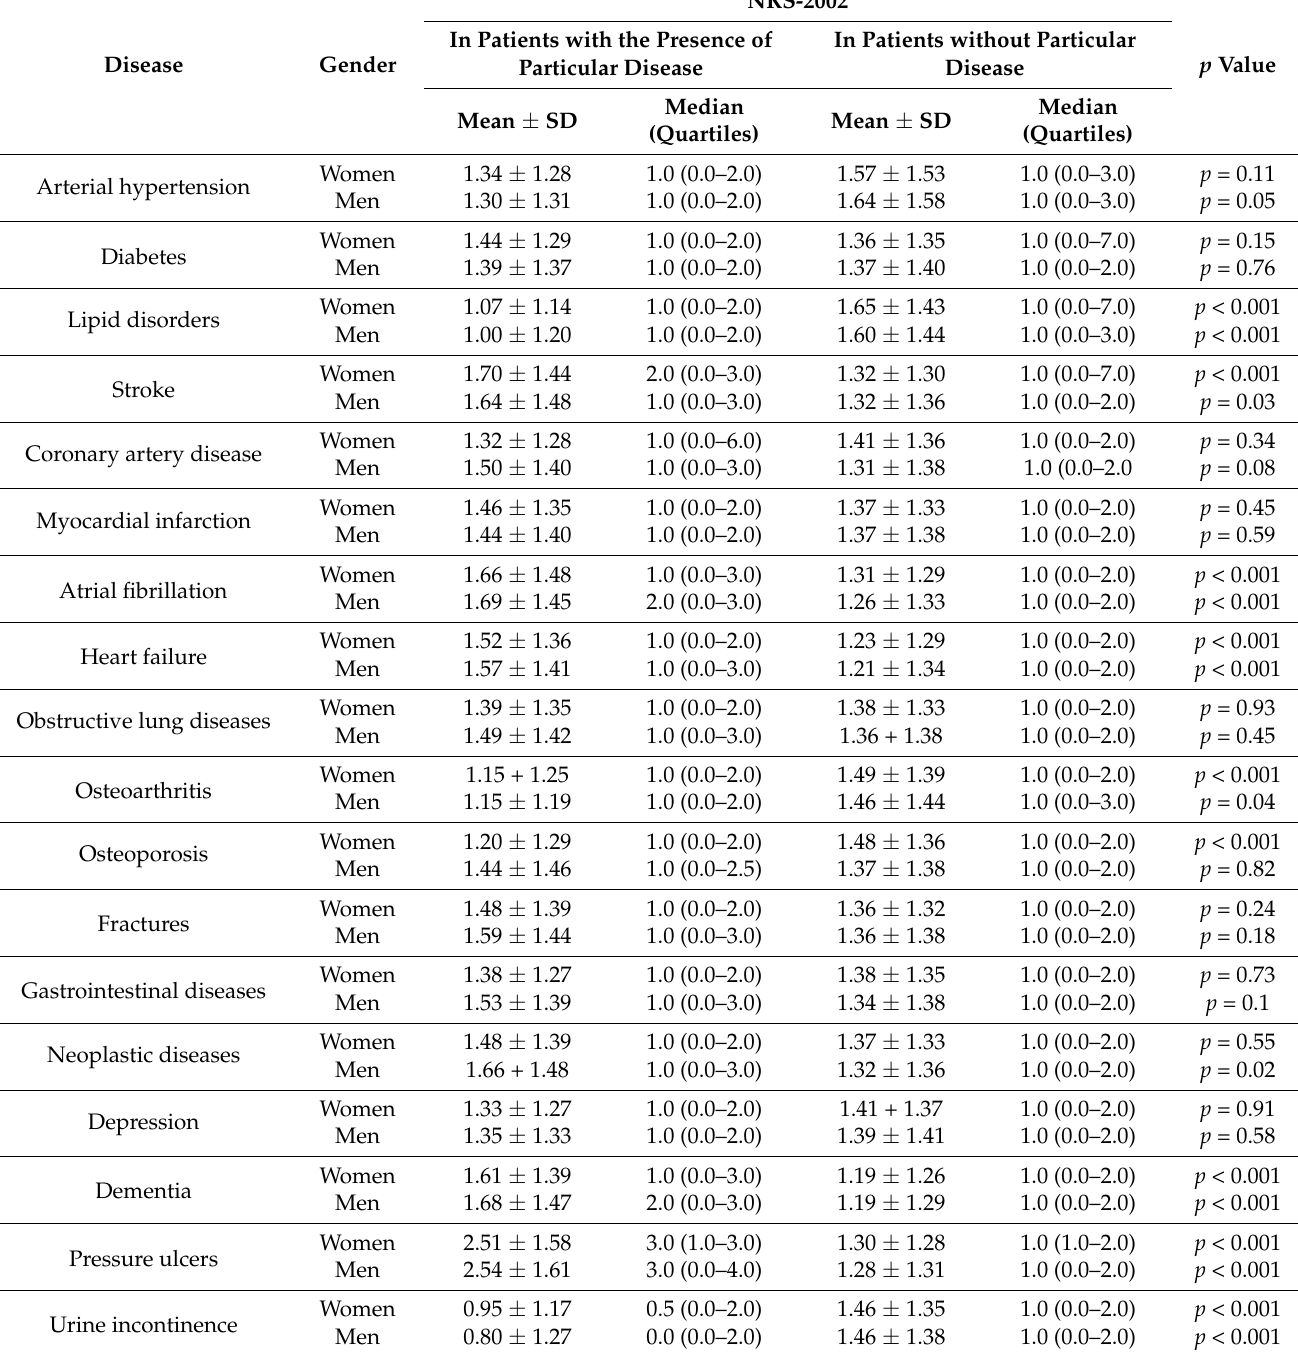
Table 2. Comparison of NRS-2002 according to the prevalence of